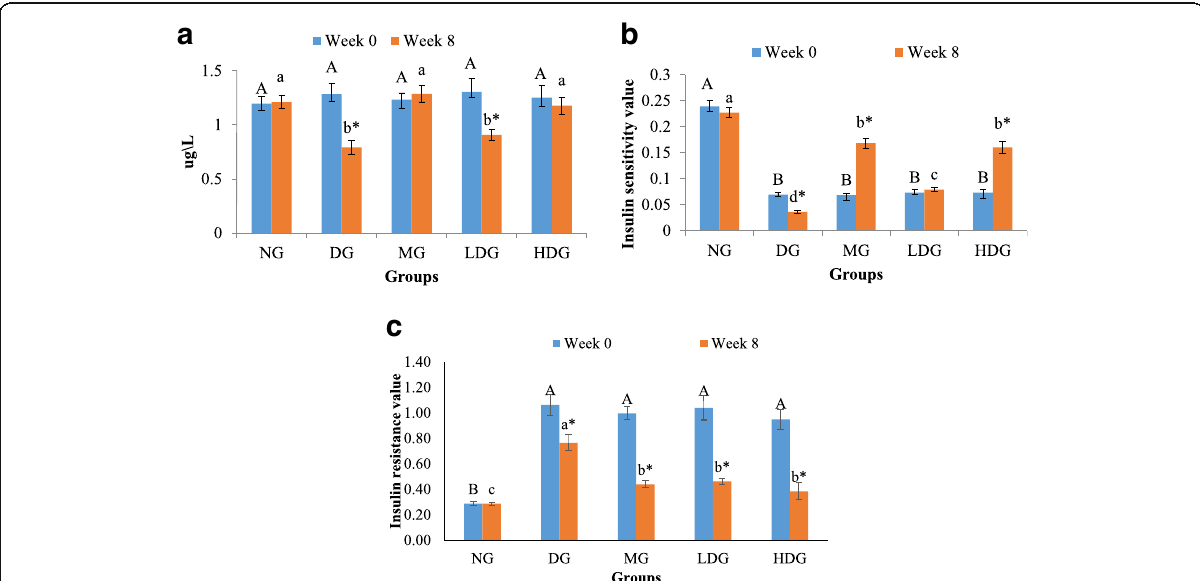
Fig. 4 a Serum insulin levels, b Insulin sensitivity values, c Insulin resistance values of normal diet group (NG), diabetic group (DG), metformin group (MG) low dose group (LDG) and high dose group (HDG) before and after